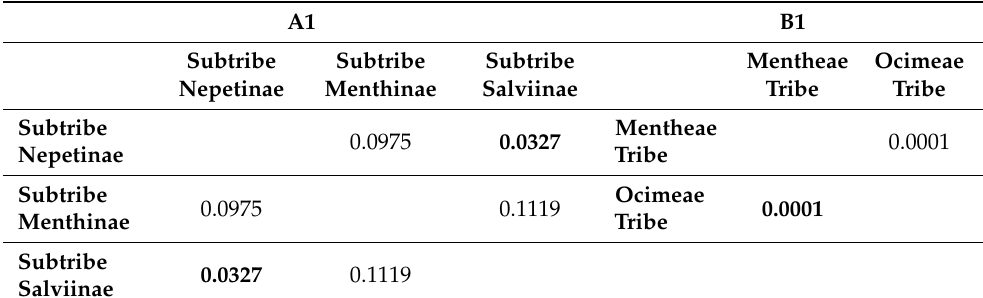
Table 2. Pairewise of one-way PERMANOVA test (Bonferroni-corrected p - value) of Subtribe ( A1 ) and ( B1 ) on VOCs. A1 B1